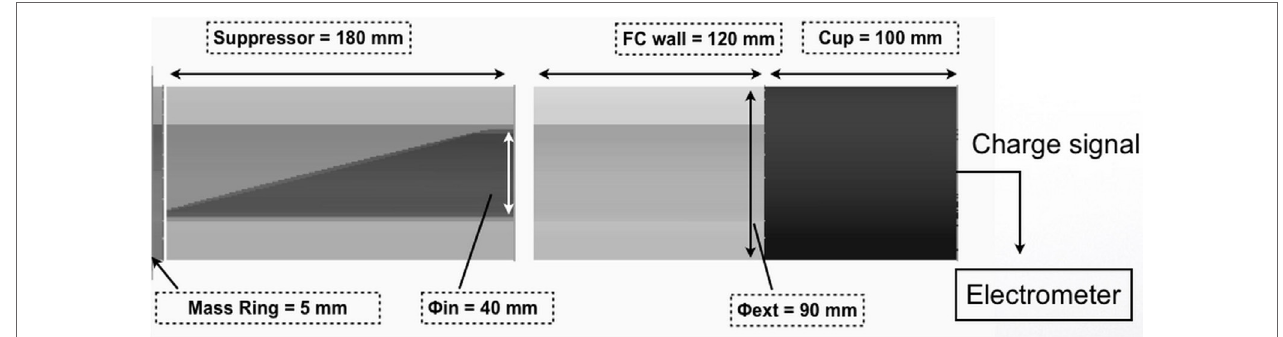
FIgURe 13 | Layout of the ELIMED Faraday Cup. Dimensions of the main components are